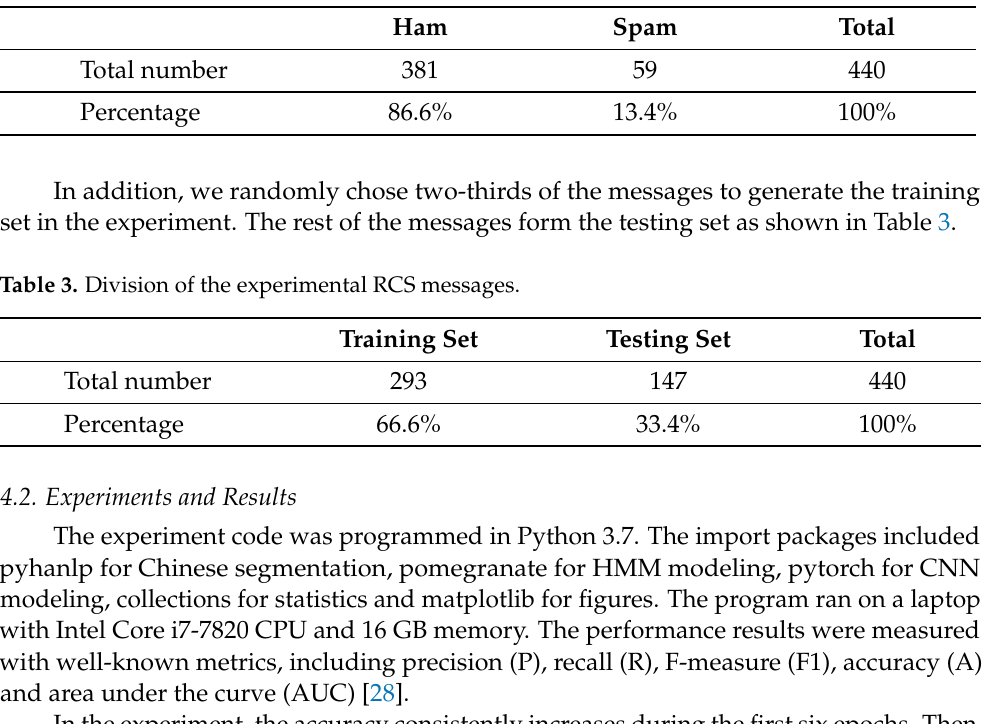
Table 2. Statistics of the experimental RCS messages.